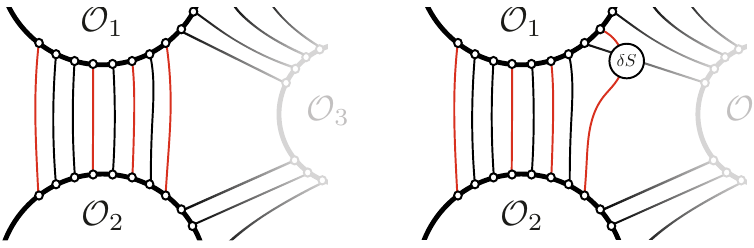
Figure 14 . The perturbative structure constant can be obtained by tree level Wick contractions of the three operators as represented in the left (cid:12)gure. In the right (cid:12)gure, the one-loop result can be concisely accommodated by inserting a lagrangian density at the splitting points where all the three operator are involved. This insertion simply accounts for the result of the Feynman diagram